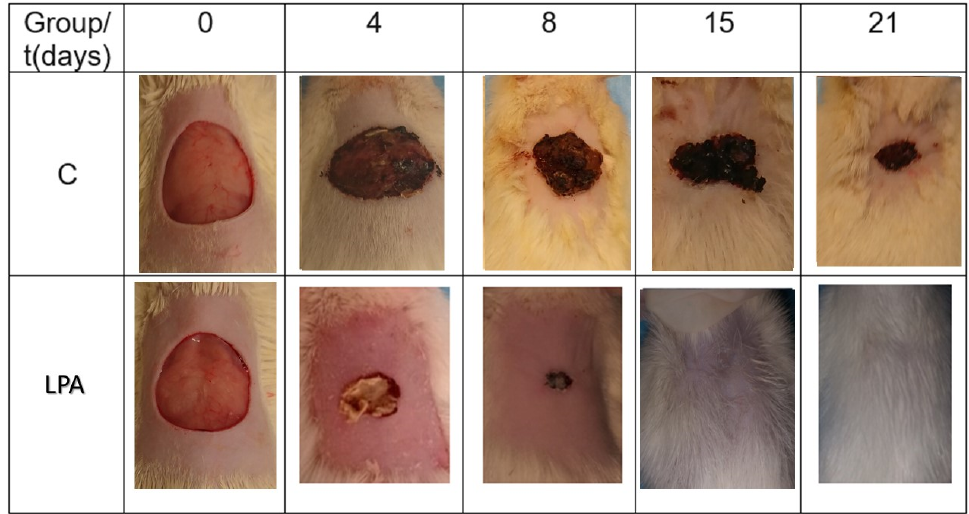
Figure 5. Wound evolution during the healing process. Table 2. Statistical analysis of the percentage size reduction of the wounds during the healing process for C 2020 and LPA, both made in triplicate.